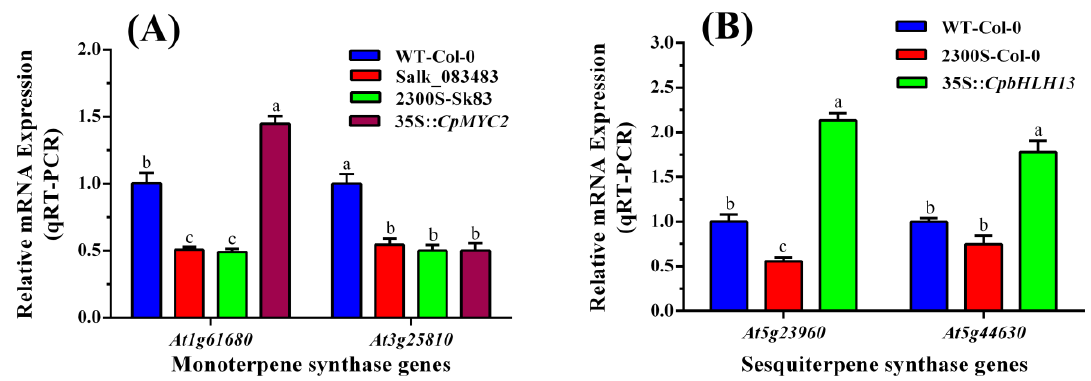
Figure 5. Expression of ( A ) the monoterpene synthase genes At1g61680 and At3g25810 in arabidopsis wild type (WT-Col-0), mutant (Salk_083483), and mutant Salk_083483 transformed by the empty vector pCAMBIA2300S (2300S-Sk83) and overexpressed CpMYC2 gene (35S:: CpMYC2 ) plants and ( B ) the sesquiterpene synthase genes At5g23960 and At5g44630 in arabidopsis wild type (WT-Col-0), wild type transformed by the empty vector pCAMBIA2300S (2300S-Col-0) and overexpressed CpbHLH13 gene (35S:: CpbHLH13 ) plants measured by qRT-PCR. The different letters on the bars show significance between the treatments by using least significant difference (LSD) at p < 0.05.